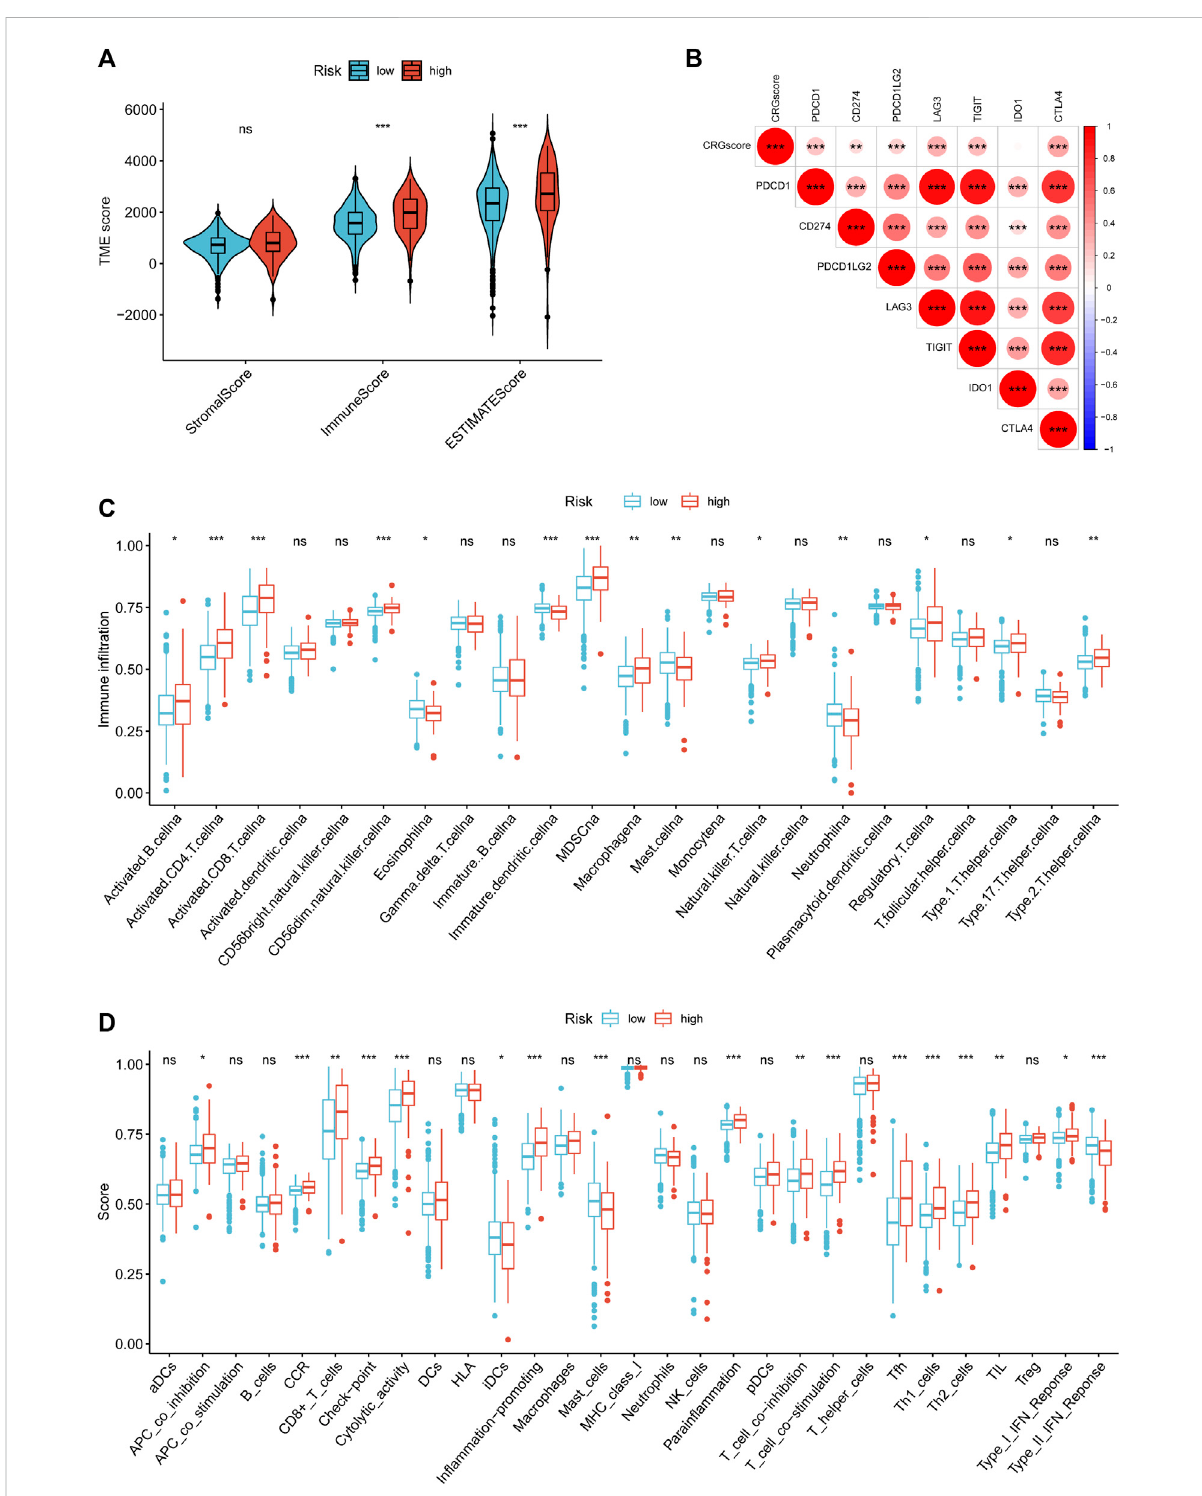
FIGURE 11 Immune cell-in fi ltrated phenotype of the CRGscore-de fi ned groups. (A) The composition of TME was calculated through the ESTIMATE algorithm. (B) The correlation between CRGscore and the expression of immune checkpoints. (C,D) TIICs in fi ltration (C) and enriched immune functions (D) were calculated with